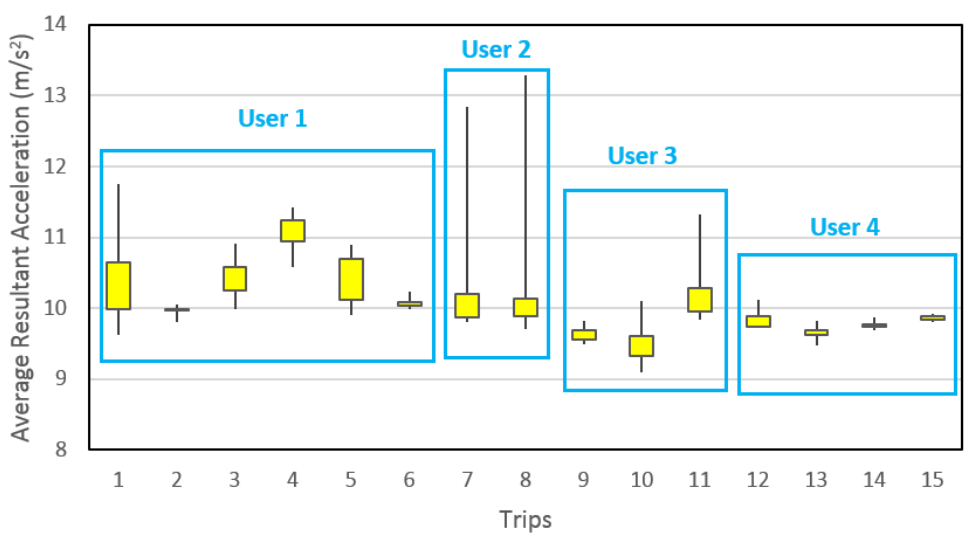
Figure 13. Convergence of data due to big window size.